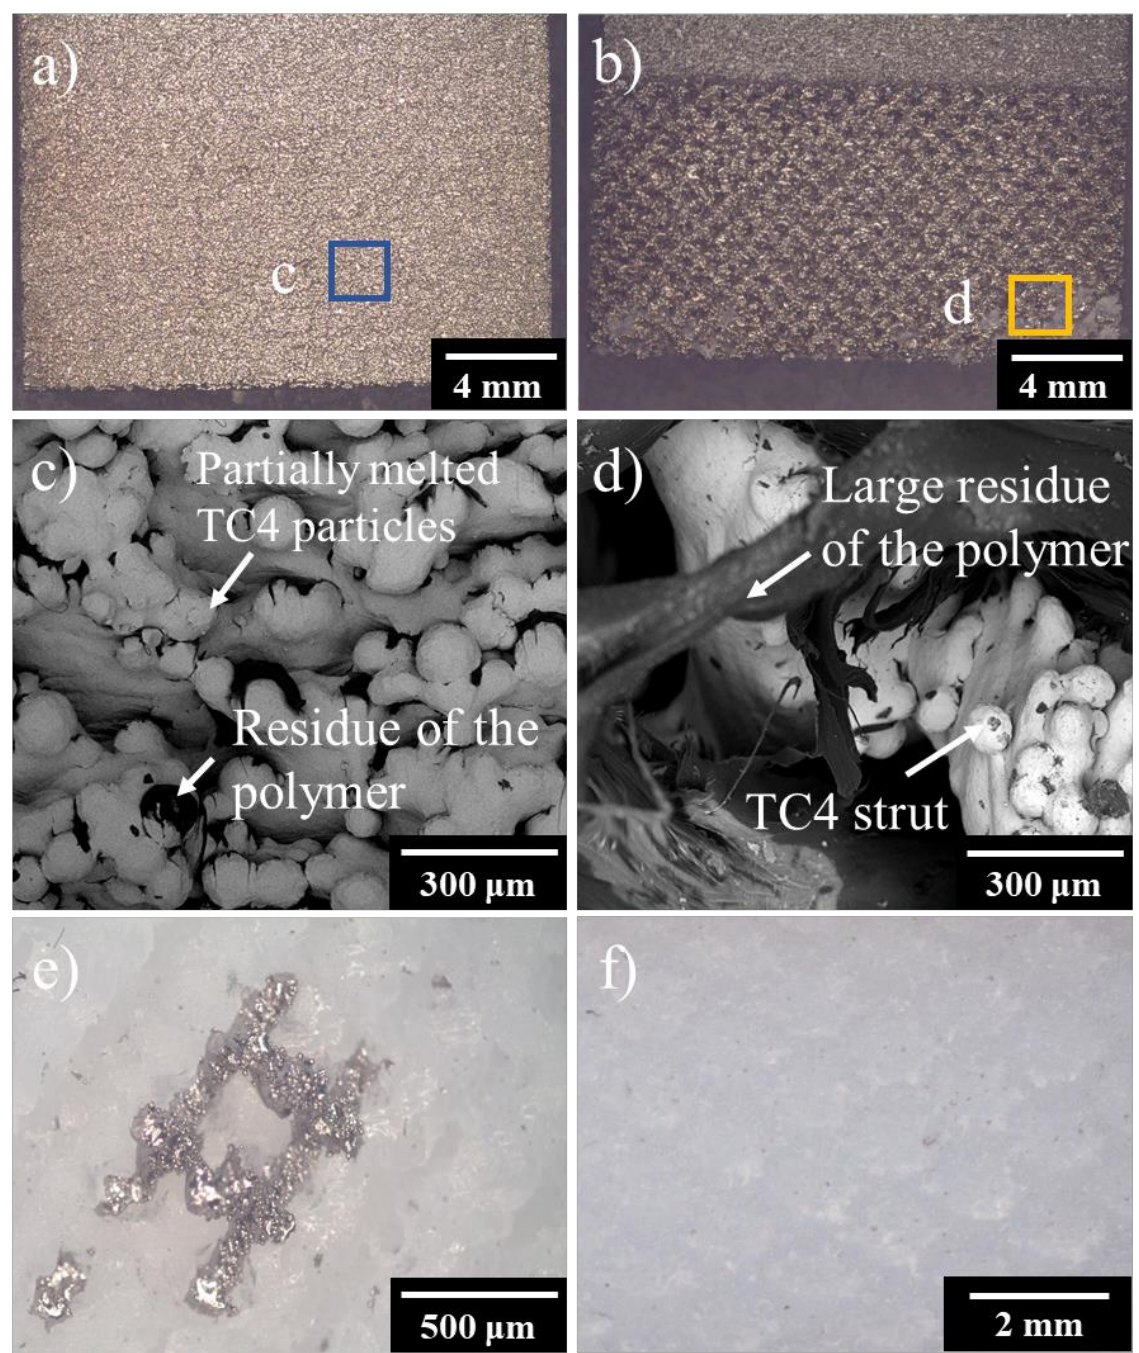
Figure 9. Micrographs showing the surfaces after joint failure: ( a , c ) metal side of the NS sample; ( b , d ) metal side of the DS architecture; ( e ) polymer side joined to the DS architecture with large amount of metal residue left; ( f ) polymer side joined to the HC architecture.